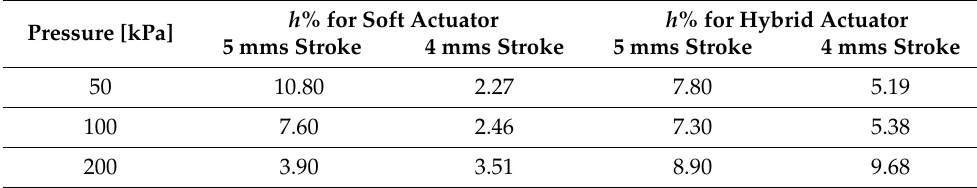
Table 4. Percentage hysteresis h % calculated for isobaric tests at 50, 100 and 200